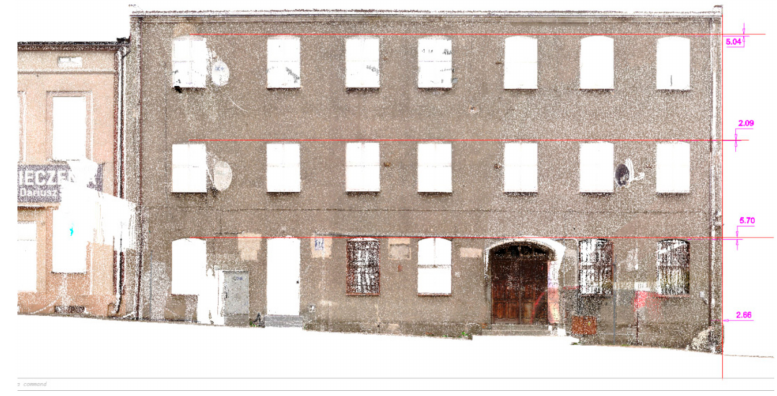
Figure 10. Outside view of the building made using TLS in Autocad 2015—Front wall with measured deformation [cm].